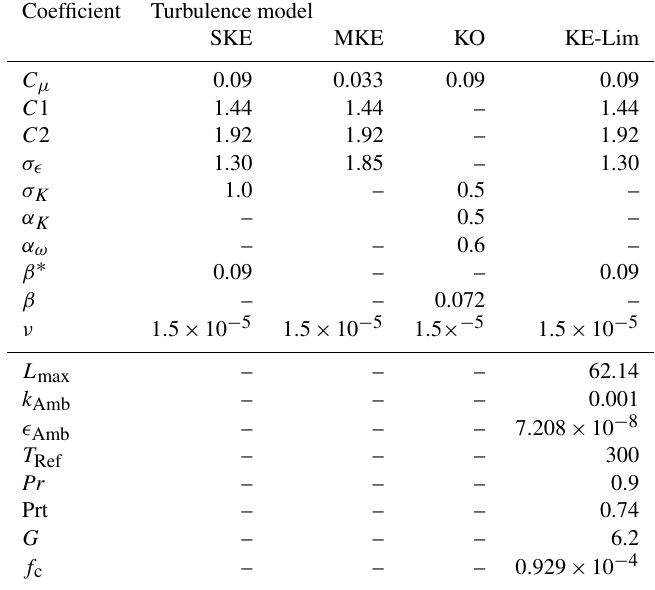
Table 3. Turbulence constants for different turbulence